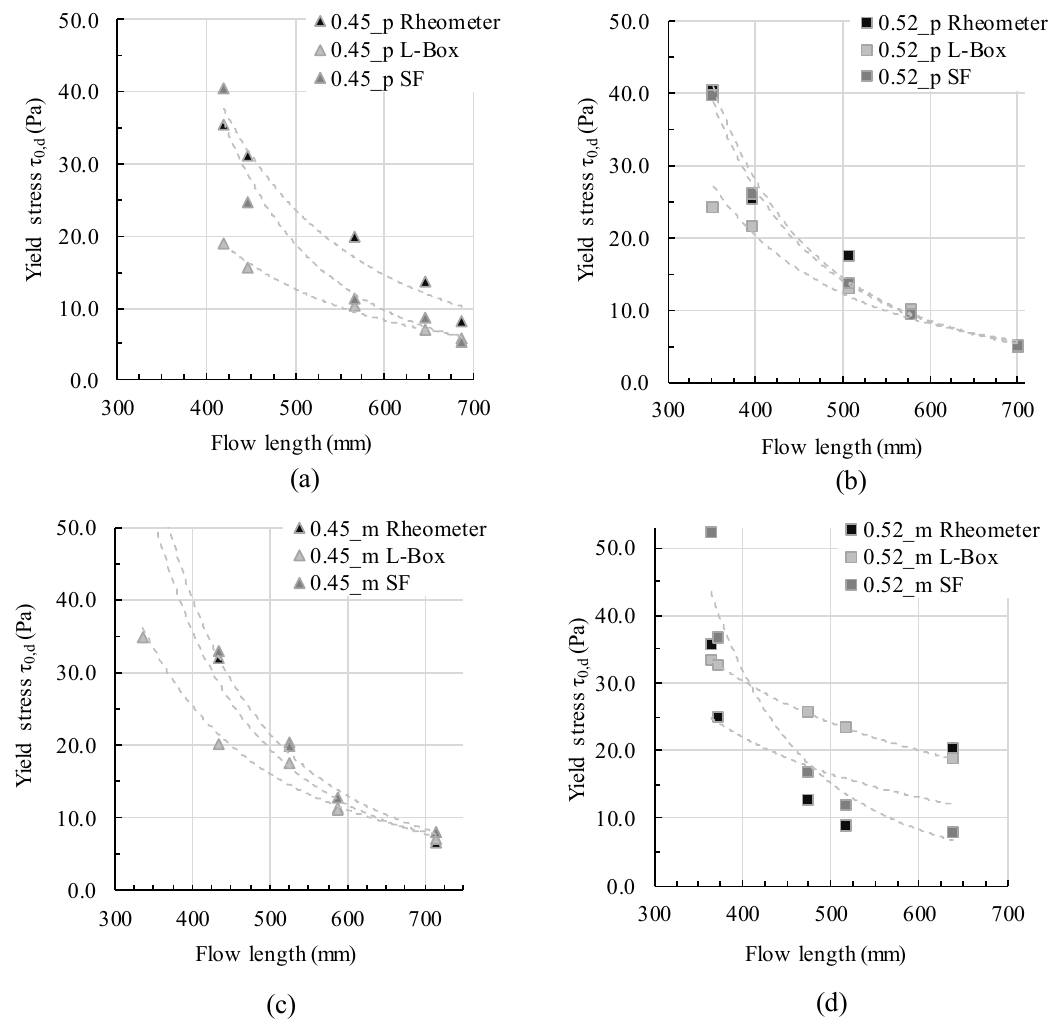
Figure 6. Flow length depending on yield stress, calculated based on rheometer data, L-box results, and slump flow diameter for ( a ) paste 0.45_p; ( b ) paste 0.52_p; ( c ) mortar 0.45_p; and ( d ) mortar 0.52_m.